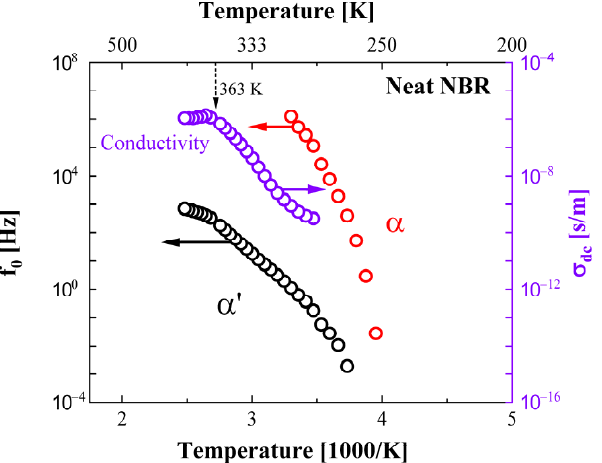
Figure 6. The variation of the central frequency for the α′ and α relaxation processes and DC conductivity versus reciprocal temperature for neat NBR. The black circles indicate the α′ process, and the violet and red circles indicate the DC conductivity and α process, respectively.